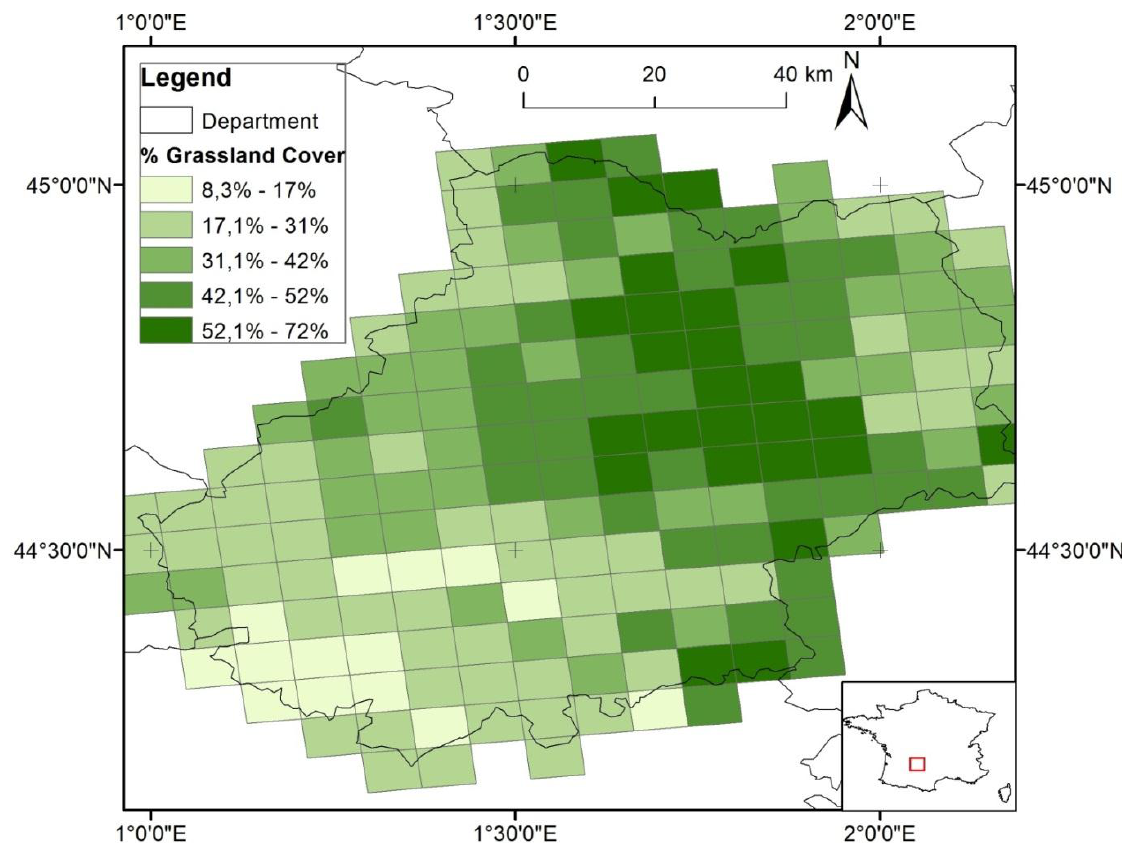
Figure 8. Geographic extent of the Lot department with the original ESUs used for indirect comparison of Forage Production Index